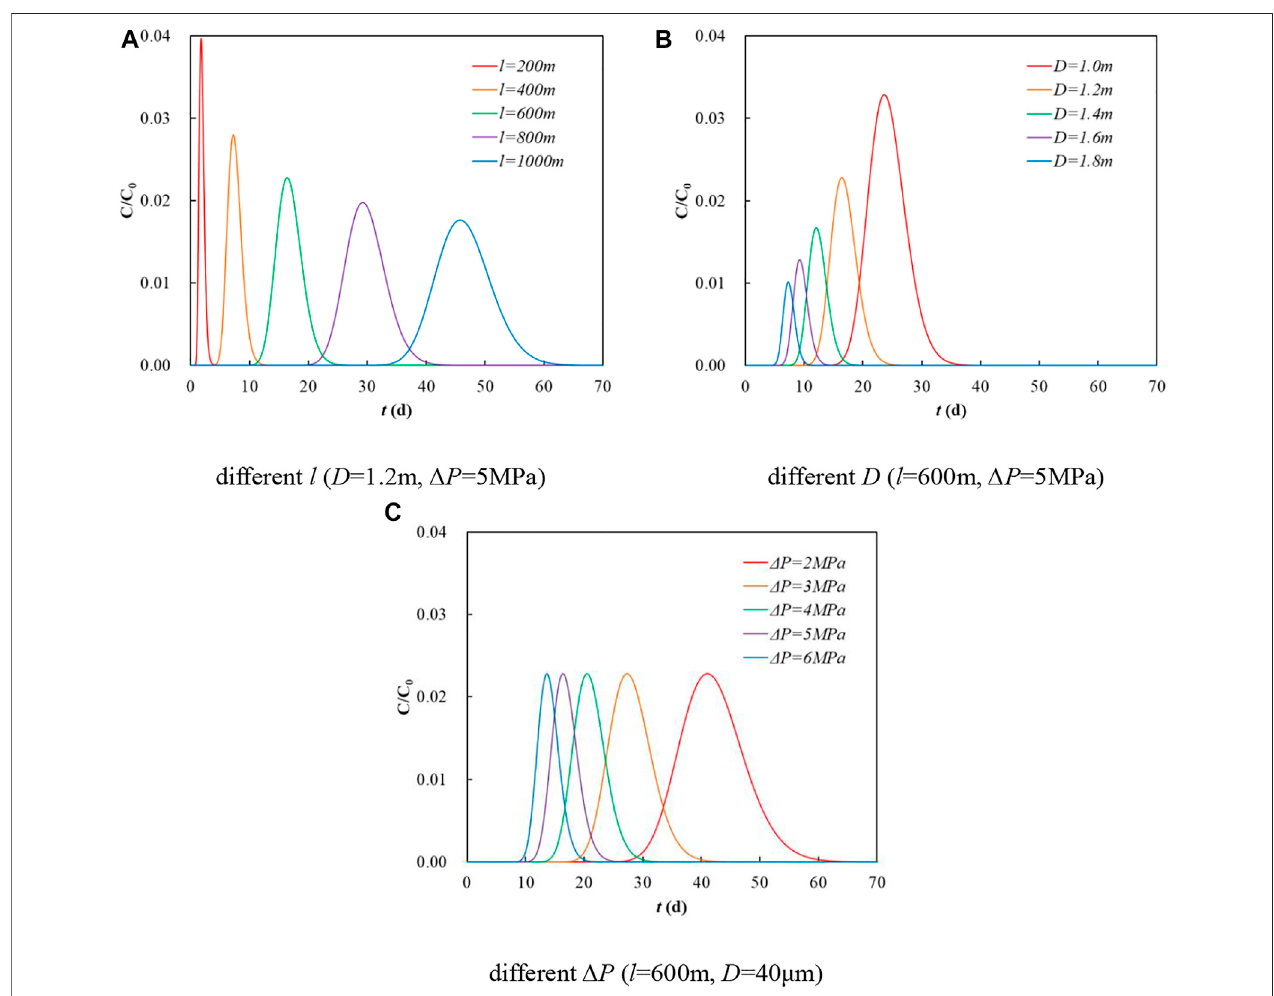
FIGURE 4 | Tracer output curve of interwell single pipe under different parameters. (A) different l ( D =1.2 m, Δ P =5 MPa) (B) different D ( l =600 m, Δ P =5 MPa) (C) different Δ P ( l =600 m, D =40 μ m).